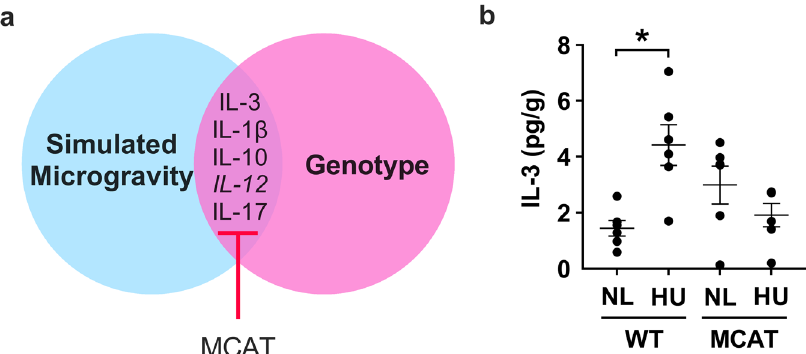
Fig. 4 Effects of simulated microgravity (without isolation) and genotype on the expression of hippocampal cytokines (social housed groups only). a Five hippocampal cytokines were differentially expressed in social housed HU versus NL mice and changes mitigated in MCAT mice. Cytokine in italics (IL-12) was downregulated while the rest were upregulated. b Representative graph showing upregulated hippocampal cytokine in social housed HU vs NL mice and mitigation in MCAT mice. Sample size is n = 6/group. Some data points overlap. *Statistically signi fi cant at p < 0.05 by two-way ANOVA and Tukey post hoc